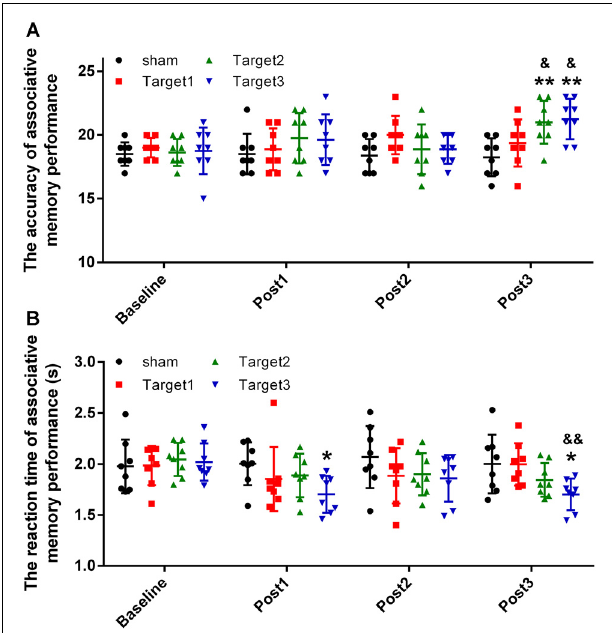
FIGURE 3 | Experimental results. (A) Stimulation-induced changes in the mean accuracy of associative memory performance. (B) Stimulation-induced changes in the reaction time of associative memory performance. Data are expressed as mean ± standard deviation. * P < 0.05, ** P < 0.01 vs. baseline group; & P < 0.05, && P < 0.01 vs. sham